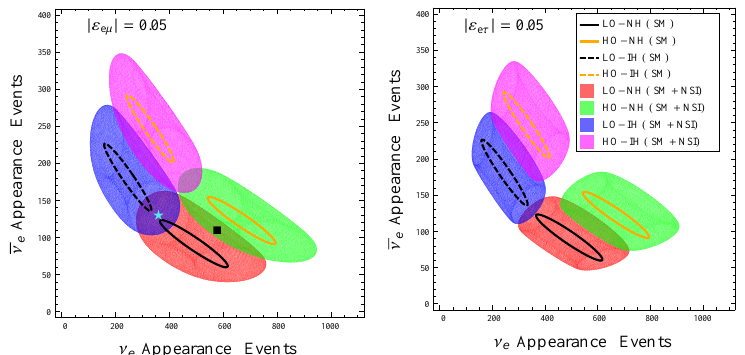
Figure 19.1: Figure represents the bi-event plot for DUNE setup. In case of SM ellipses, the running parameter is δ , whereas in case of SM + NSI blobs, the running parameters are δ and φ ( δ and φ ) in the left (right) panel respectively. For e µ e τ details please see the text and [ 35 ] . This figure has been taken from [ 35 ]